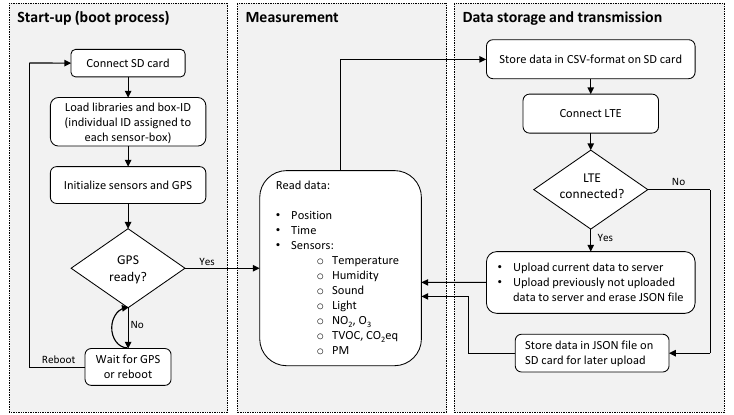
Figure 2. Software flow chart: sensor-box data acquisition and transmission